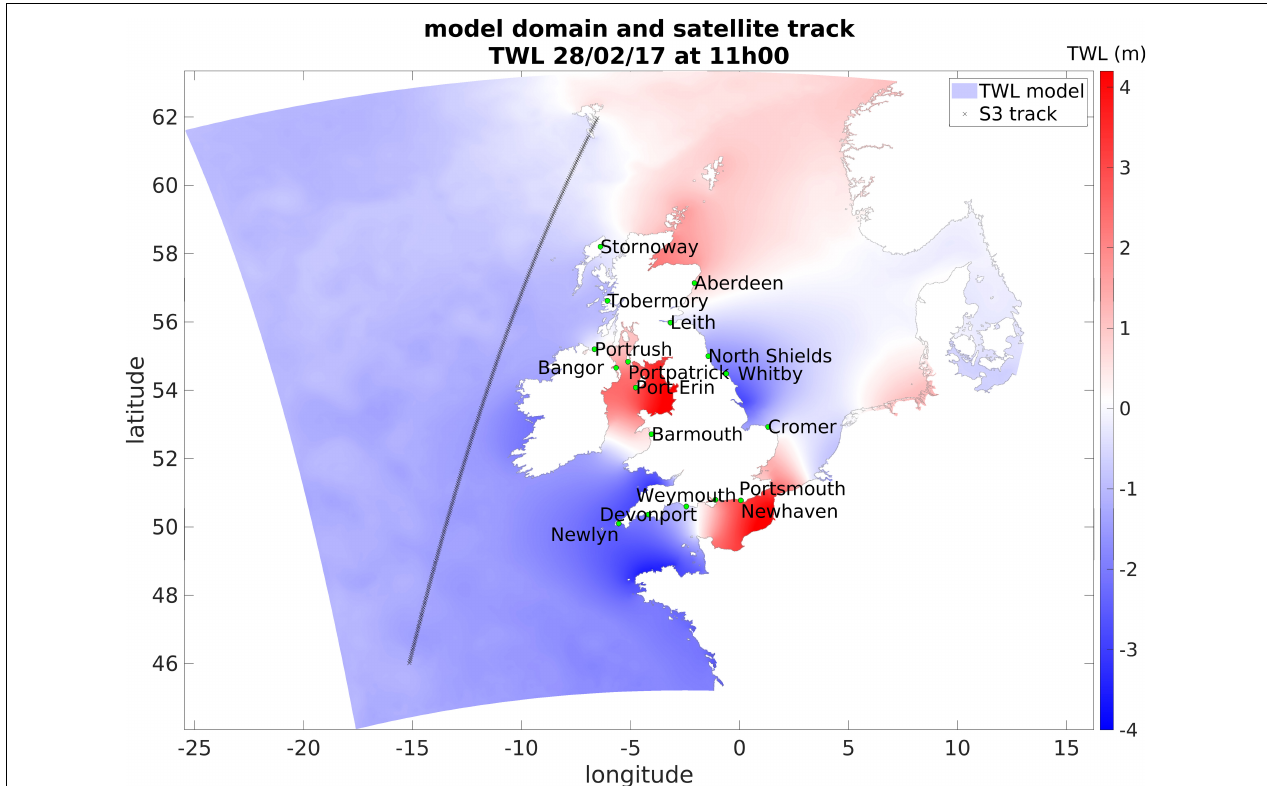
FIGURE 1 | Snapshot of Amm15 coupled model domain showing TWL at 1100h on 28 February 2017 during Storm Ewan. The respective Sentinel-3 satellite track over the domain in that hour is also shown. The locations of the tide gauges used for comparisons with the satellite data are marked on the plot with green